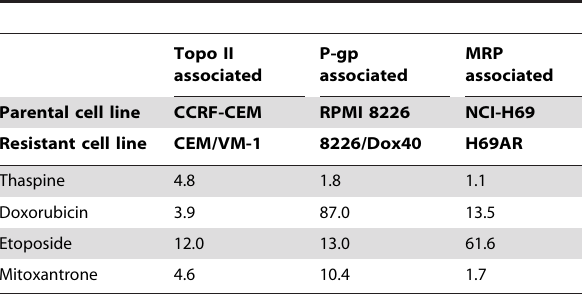
Table 2. Influence of resistance mechanisms on cytotoxic potency of thaspine and standard topoisomerase inhibitors.